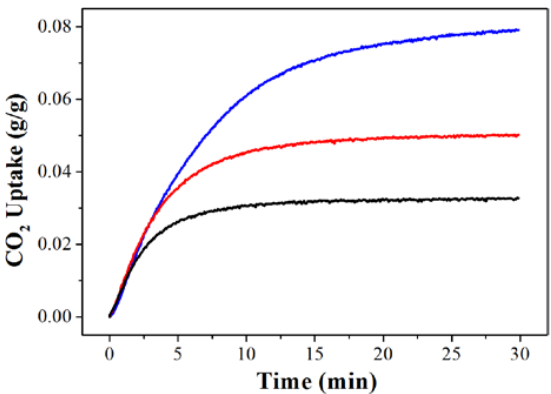
Figure 1. Plot of CO 2 uptake for nitrogen- and sulfur-doped porous carbon (NSPC) as a function of time using pure CO 2 at 1 atm at the temperatures of 24.5, 44.7, and 65.0 °C in blue, red, and black, respectively.